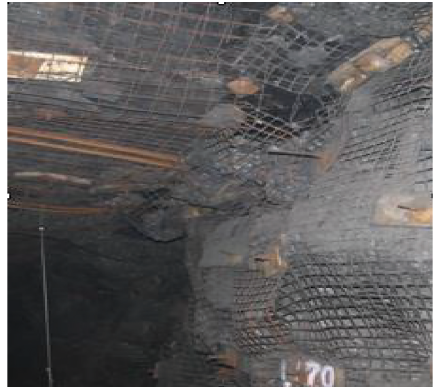
Figure 1: Large deformation of roadway in Mentai Buliangou Coalfield.